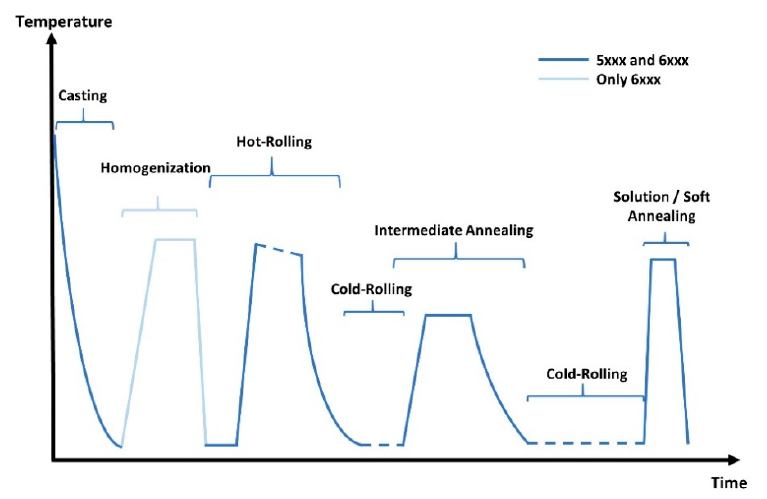
Figure2. Schematically illustratedprocess route for ENAW-5182(no homogenization) andEN Figure 2. Schematically illustrated process route for EN AW-5182 (no homogenization) and EN AW- 6016.